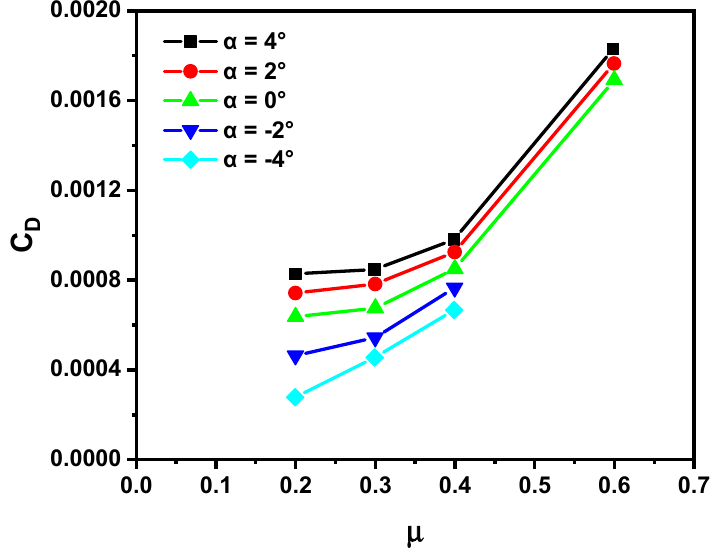
Figure 13. Drag force coefficient (C D ) as a function of the advance ratio ( μ ), 1100 rpm.